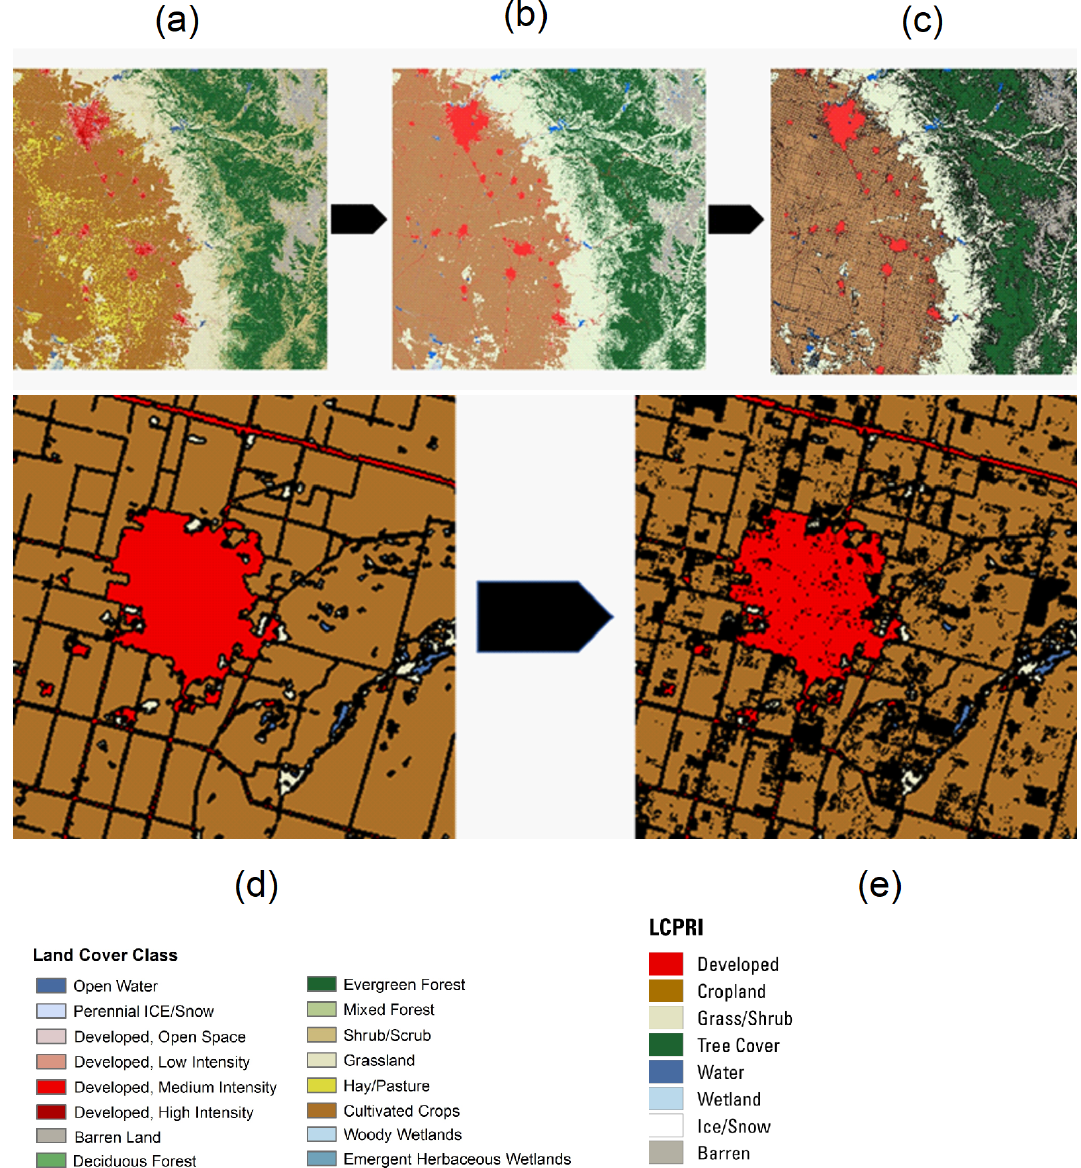
Figure 4. NLCD 2001 land cover (a) , cross-walked LCMAP land cover classes (b) , LCMAP land cover eroded by 1pixel (c) , zoomed-in cross-walked land cover from NLCD 2001 (d) , and zoomed-in LCMAP land cover classes eroded by 1pixel (e) . The color legends represent the NLCD land cover class and LCMAP primary land cover